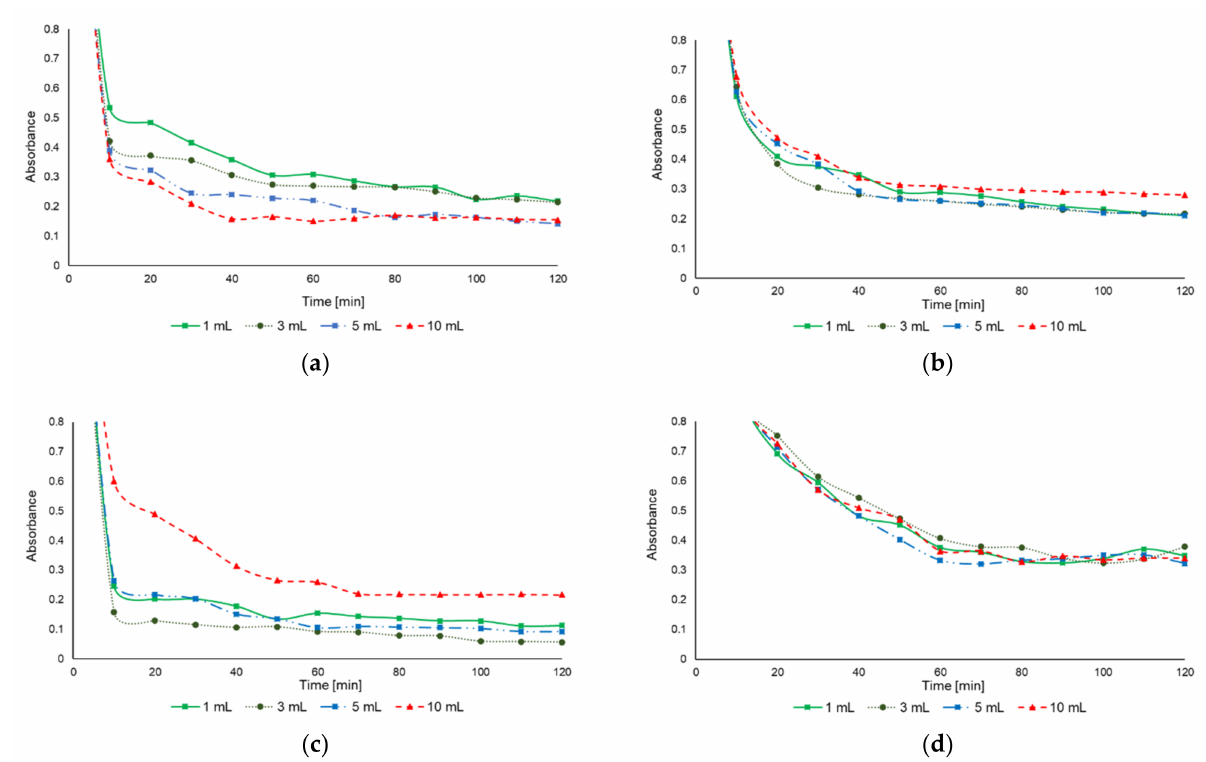
Figure 9. Absorbance for kaolin aqueous suspension as a function of time at different doses of: ( a ) St-5PAM-1CS; ( b ) St-5PAM-3CS; ( c ) St-7PAM-1CS; or ( d )